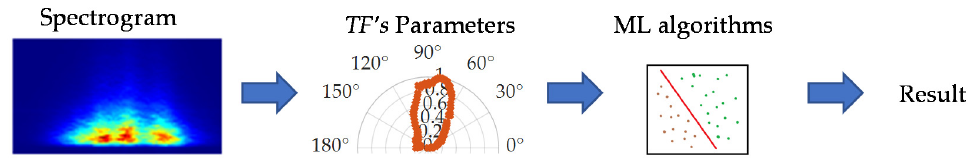
Figure 6. Scheme of data workflow.